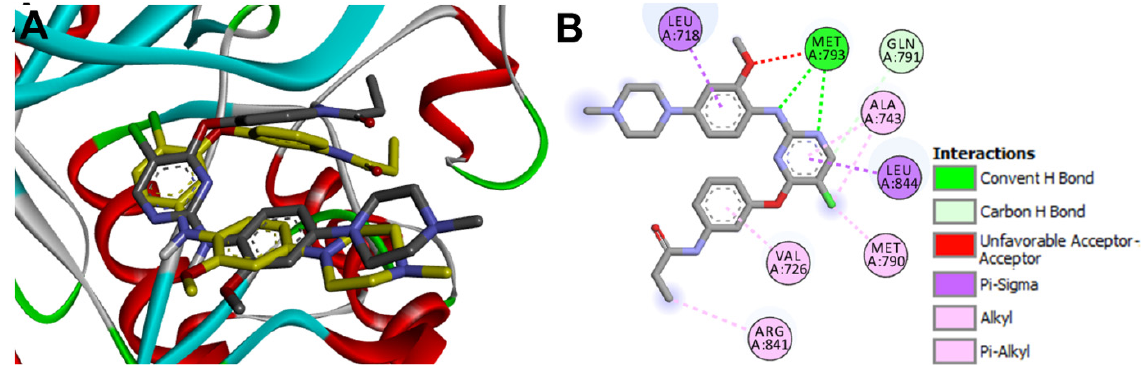
Figure 15. Binding mode/interactions of WZ4003 (shown as ticks colored by element) into EGFR T790M (pdb: 5X2K): ( A ) 3D binding mode of the redocked WZ4003 overlaid with the co-crystallized ligand, WZ4003 (yellow sticks); ( B ) 2D binding mode of the co-crystallized WZ4003 showing different types of the binding interactions with amino acids in the active site of EGFR.